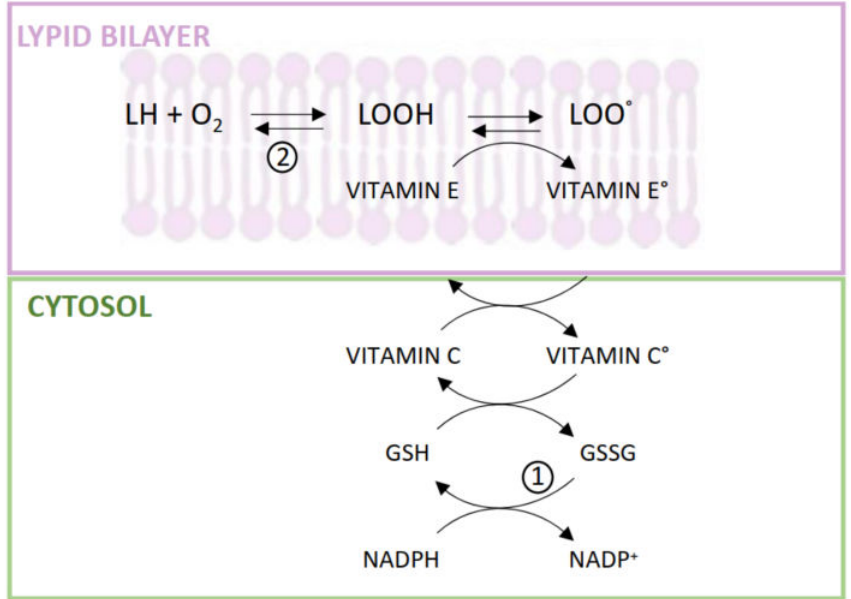
Figure 3. Interaction between hydrophilic antioxidants and vitamin E in the scavenging of lipoperoxyl radicals formed in the cellular membrane. Abbreviations: L, membrane lipids; Vitamin E ◦ , tocopheryl radical; Vitamin C ◦ , ascorbyl radical; GSH and GSSG, reduced and oxidized glutathione; NADP+ and NADPH, nicotinamide-adenine-dinucleotide phosphate oxidized and reduced-form. (1) Hexose monophosphate shunt and GSH-reductase activity; (2) Membrane GSH-peroxidase